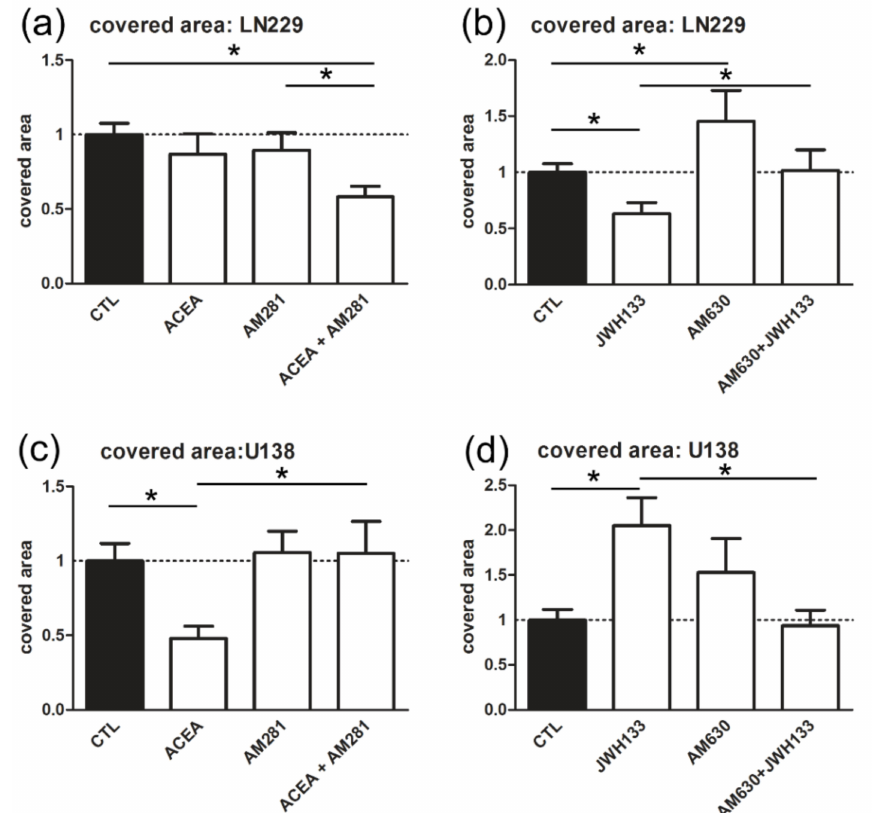
Figure 5. Invasiveness of glioblastoma cells was analyzed in a co-culture model with murine organotypical slice cultures. ( a , b ) Treatment with AM281 (1 µ M) had no significant effect on the covered area, whereas coincubation of AM281 with ACEA (10 µ M) led to strong anti-invasive effect in LN229. Application of AM630 (1 µ M) alone led to significant increase in invasiveness of LN229. Treatment with combination of AM630 with JWH133 reversed the JWH133 (10 µ M) mediated reduction in invasiveness indicating that previously observed decrease in covered area was mediated by CB 2 receptor (LN229: n LN229 CTL = 60, n LN229 ACEA = 34, n LN229 AM281 = 33, n LN229 ACEA+AM281 = 35, n LN229 JWH133 = 18, n LN229 AM630 = 19, n LN229 JWH133+AM630 = 15). ( c , d ) Coincubation of ACEA and AM281 reversed the decrease in the covered area mediated by ACEA in U138-MG cells. Incubation with JWH133 led to an increase in the invasiveness, which was abolished by co-application with AM630 (U-138 MG: n U138 CTL = 69, n U138 ACEA = 23, n U138 AM281 = 32, n U138 ACEA+AM281 = 21, n U138 JWH133 = 32, n U138 AM630 = 24, n U138 JWH133+AM630 =